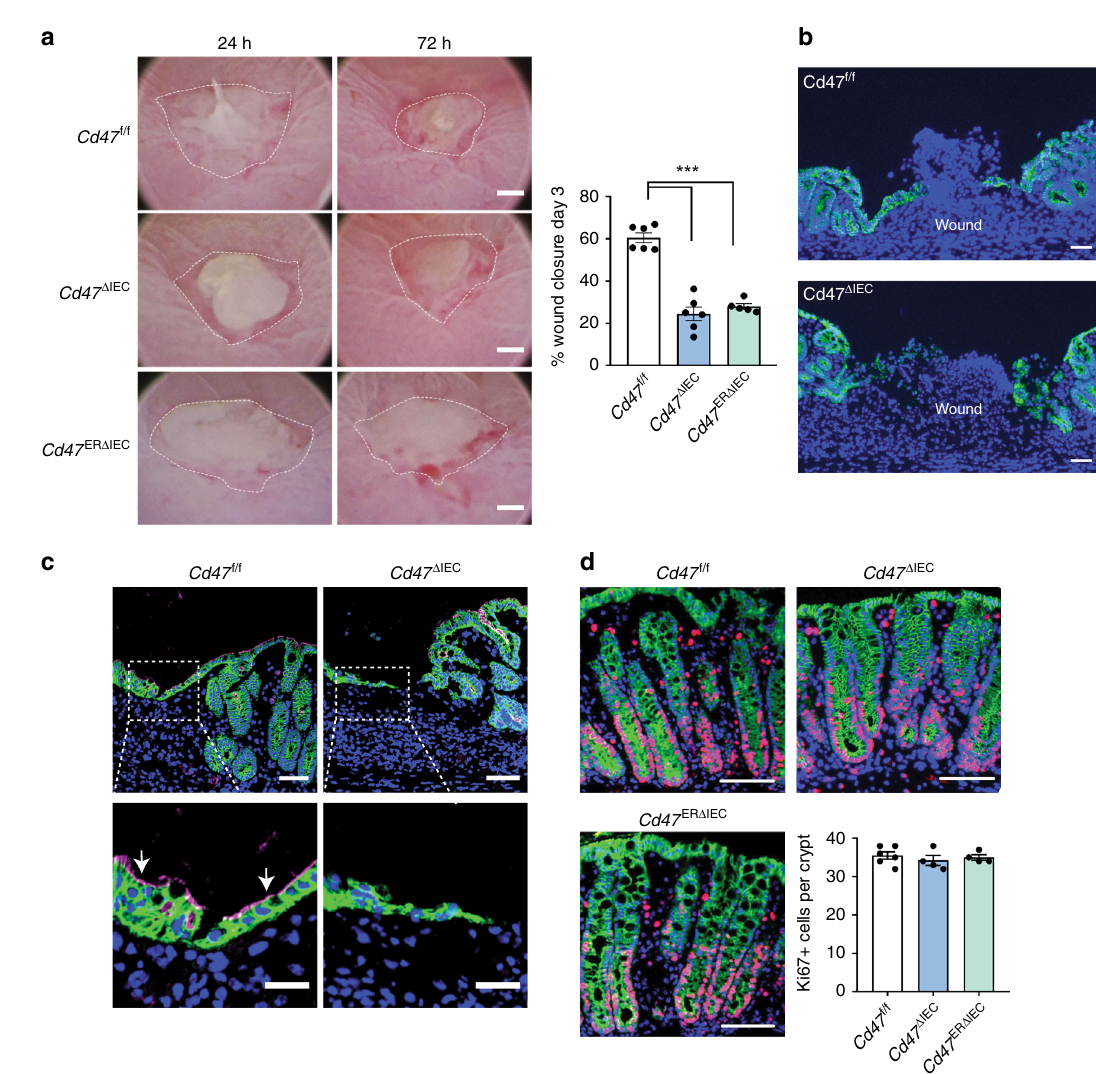
Fig. 3 IEC-speci fi c deletion of CD47 results in impaired mucosal healing. Utilizing a miniature video endoscope and biopsy scissors, 5 – 7 wounds were created in the dorsal aspect of the descending colon mucosa of anesthetized mice. Cd47 ER Δ IEC mice were wounded 2 weeks after tamoxifen treatment. a Digital measurement of wound surface area at 24 and 72 h post wounding revealed a striking impairment in wound closure in Cd47 Δ IEC and tamoxifen- treated Cd47 ER Δ IEC mice. Points represent mean value within all wounds from an individual mouse. Data are representative of two independent experiments with 5 – 6 mice per group. Data are means ± SEM. *** p < 0.001; one-way ANOVA. b Tissue sections taken from day 3 wounds were stained with the epithelial-speci fi c marker E-Cadherin (green), plus DAPI counterstain (blue). Re-epithelialization of the wound is disorganized in the absence of CD47 ( Cd47 Δ IEC ) compared with control Cd47 f/f . c Tissue sections taken from day 3 wounds were stained with the epithelial-speci fi c marker E-Cadherin (green), brush border protein Villin (magenta), and DAPI (blue). Insets of epithelial cells on top of the wound bed show polarized wound-associated epithelial cells (WAE) expressing Villin (arrows) in Cd47 f/f wounds while cells are not polarized in Cd47 Δ IEC wounds. Scale bars = 100 μ m. d Ki67 staining of frozen sections of wounded colon mucosa 3 days post-wounding (red) revealed similar proliferation rates in crypt epithelial cells immediately adjacent to wounds in the absence of epithelial CD47. Sections were counterstained with E-Cadherin (green) and DAPI (blue). Scale bars = 50 μ m. Points represent the average number of Ki67-positive cells for four crypts adjacent to wounds for each individual mouse. Data are means ± SEM and are representative of two independent experiments with 4 – 6 mice per group. Source data are provided as a Source Data fi